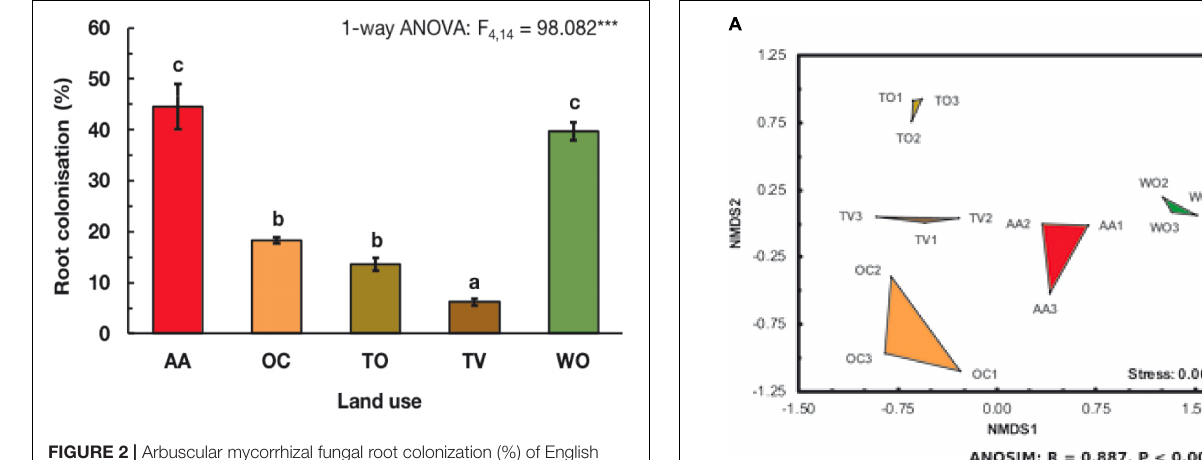
Frontiers in Microbiology |